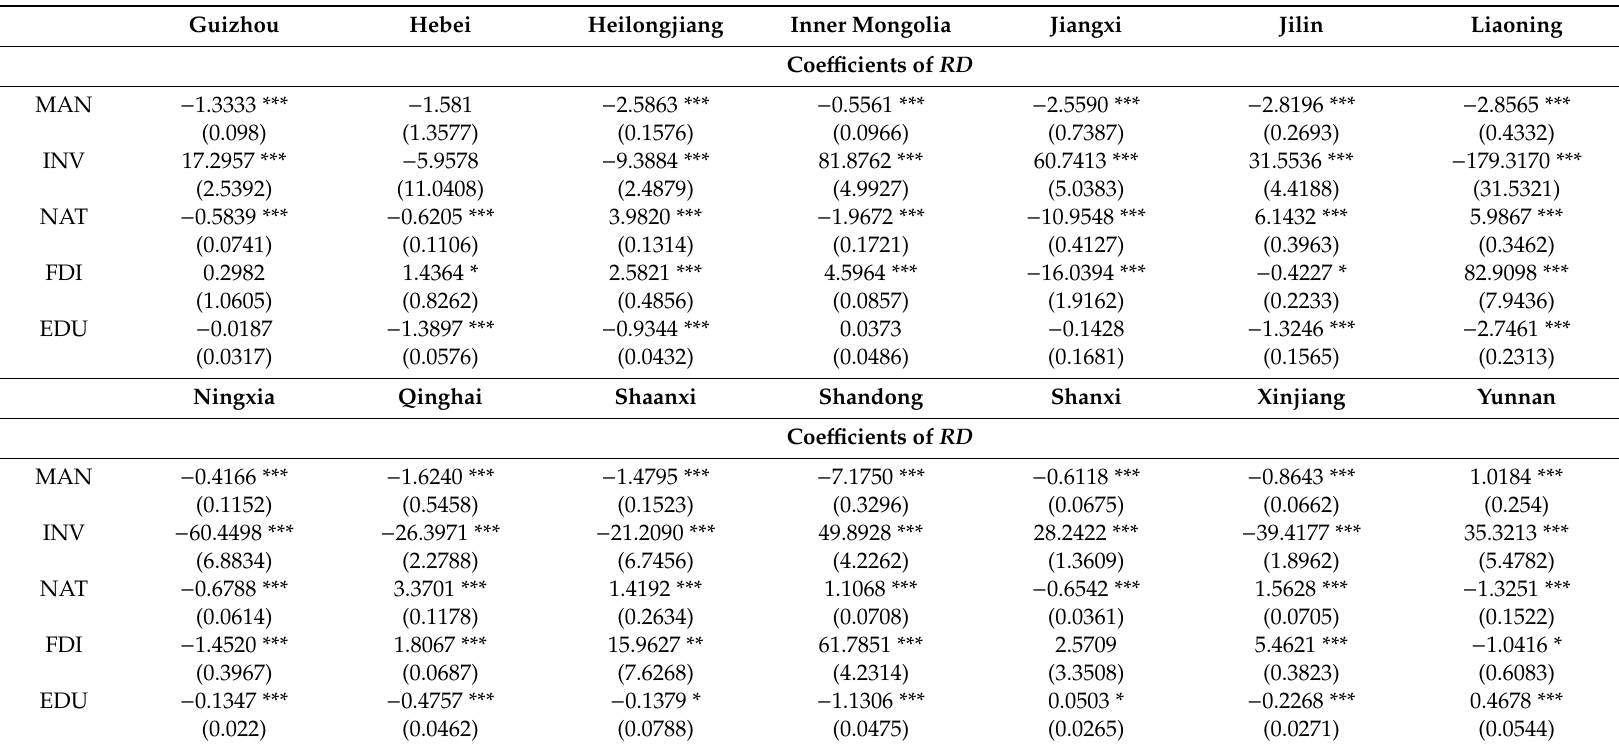
Table 6. Regressions for transmission